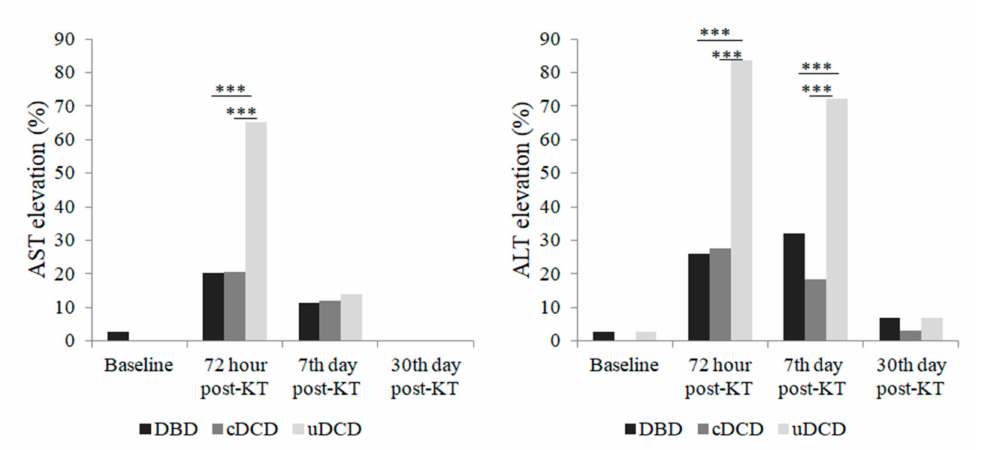
Figure 3. Percentage of patients with elevated AST or ALT according to donor type (only those recipients who received thymoglobulin). Comparisons between groups were made with Chi-Square test. Differences were found in the uDCD group at 72 h post-KT (AST levels) and at 72 h and 7 days post-KT (ALT levels). *** p <